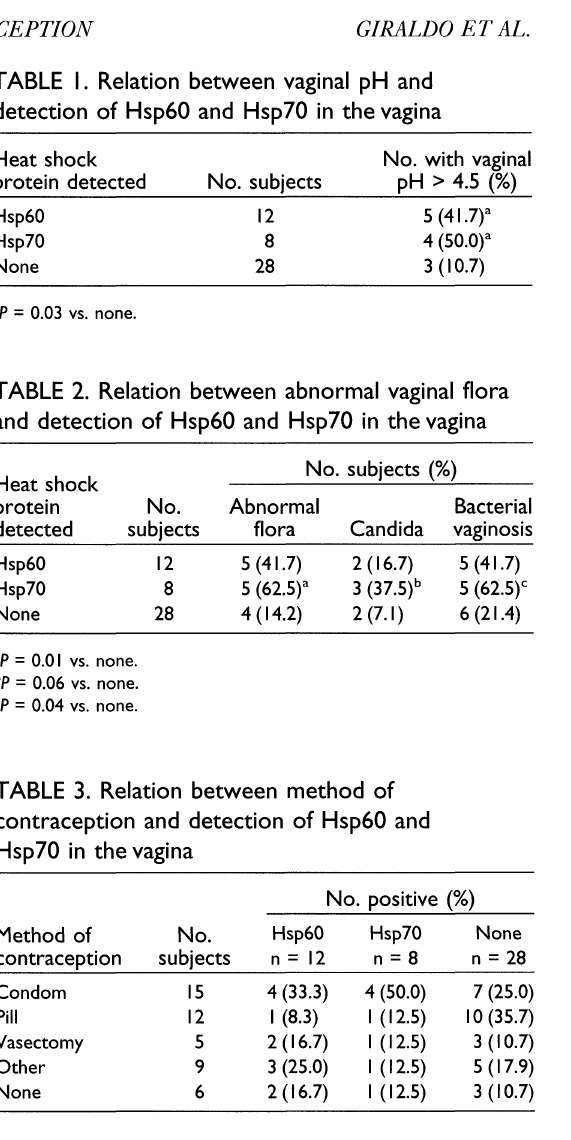
TABLE I. Relation between vaginal pH and detection of Hsp60 and Hsp70 in the vagina Heat shock